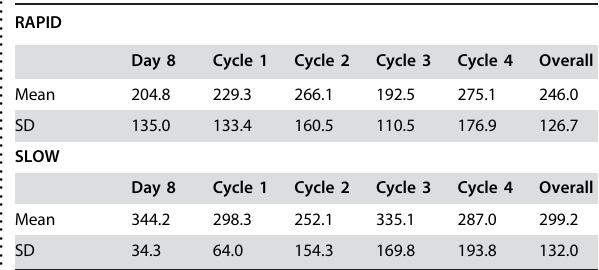
Table 5. Hydralazine plasmatic levels according to